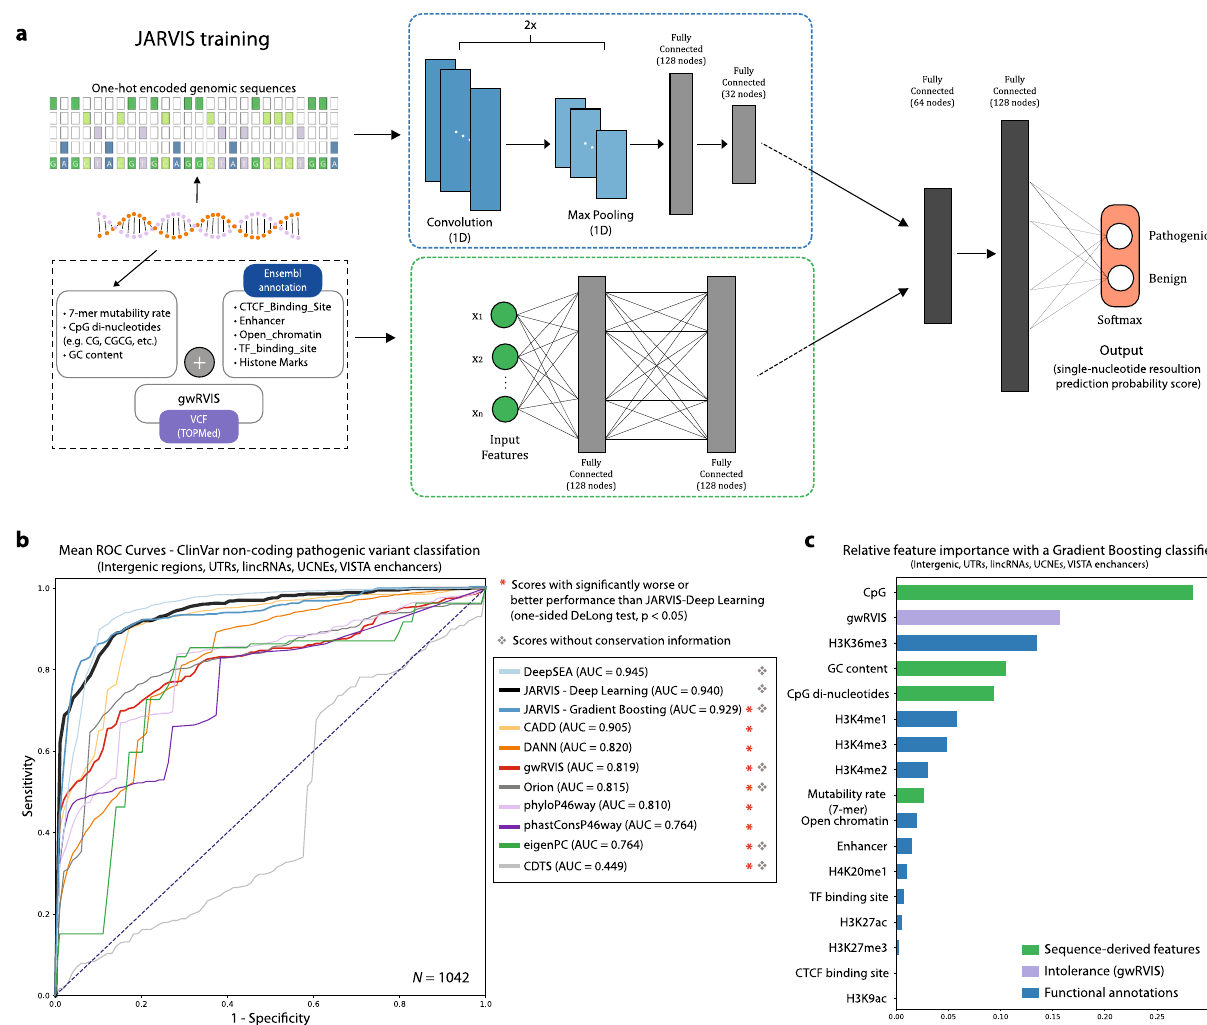
Fig. 4 JARVIS: a multi-module deep-learning-based score for non-coding variants pathogenicity inference with single-nucleotide resolution. a Deep- learning framework for noncoding variants pathogenicity inference based on different types of annotation: genome-wide residual variation intolerance score (gwRVIS), primary genomic sequence, structured features extracted by raw genomic sequence (mutability rate, GC content, etc.) and additional annotations from Ensembl (histone marks, chromatin accessibility, CTCF-binding sites, etc.). All structured features are initially passed onto a two-layer deep neural net (DNN). Primary genomic sequences (in windows of 3 kb) are fed into a deep convolutional neural net and then fl attened prior to merging with the higher representations of the structured features previously processed by the DNN. The combined higher representations of features are processed by two additional fully connected layers, followed by a “ softmax ” output, which gives the pathogenicity likelihood for each input variant as a probability score. b JARVIS performance with fi vefold cross-validation after training with a multi-module deep neural network, using all noncoding ClinVar- based pathogenic variants and a matched set of putative benign variants from denovo-db. Variants used for training belong to any of the following genomic classes: intergenic regions, UTRs, lincRNAs, UCNEs, or VISTA enhancers. A total of 521 noncoding pathogenic variants have been used for this classi fi cation task, thus N = 1042 represents the total size of the training set (using a set of control variants of equal size). Performance for the rest of the genome-wide scores shown here has been calculated using a logistic regression model with fi vefold cross-validation on the JARVIS training set. c An overview of the relative importance of the structured features integrated within JARVIS, as they are extracted by a Gradient Boosting classi fi er following an impurity-based feature selection